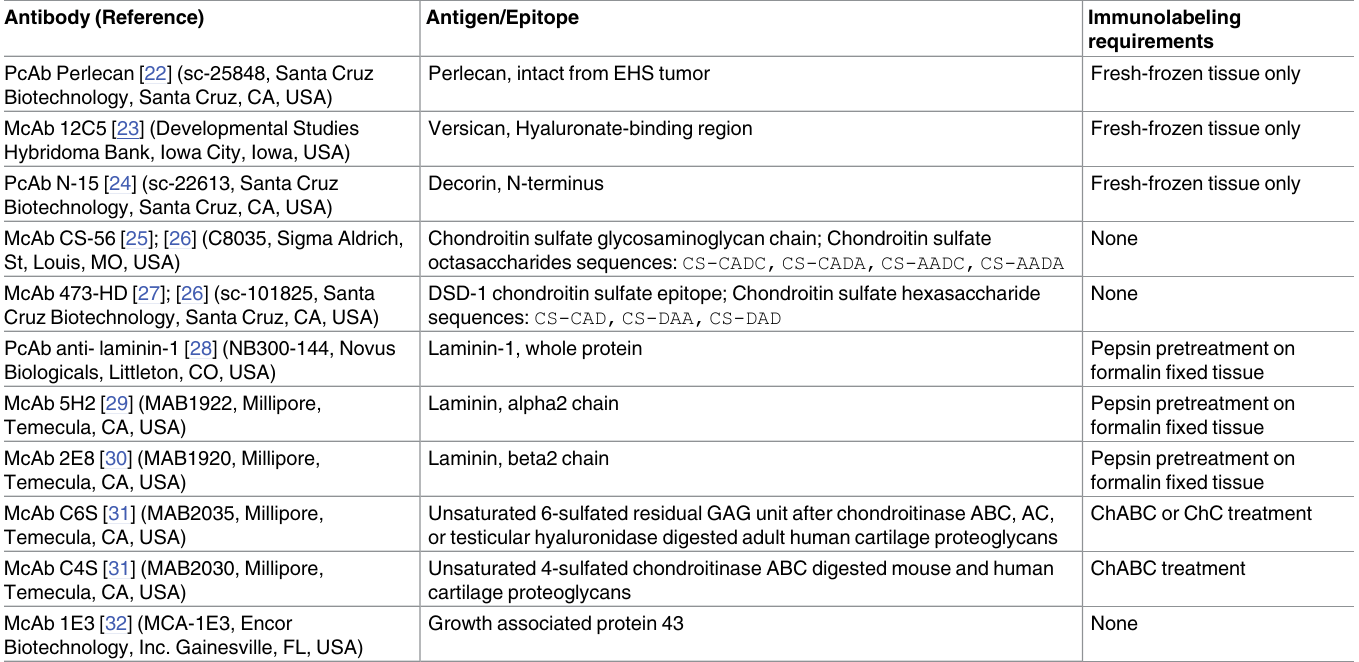
Table 1. Antibodies and